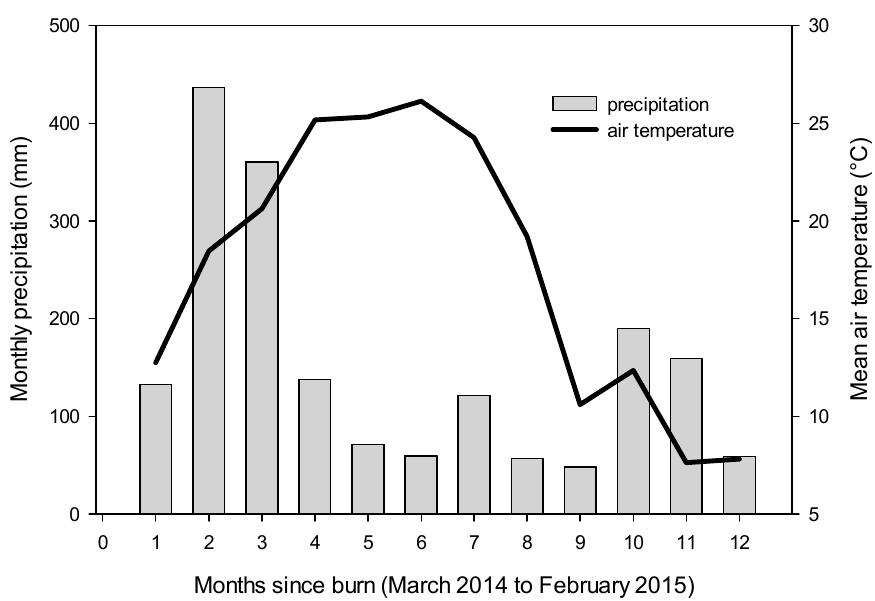
Figure 2. Monthly precipitation and monthly mean air temperature at the Harrison Experimental Forest near Saucier, Mississippi, for the 12 months following prescribed burning on 28 February 2014. A metal marker was placed at the center of each pre-existing 0.2 ha plot where a circular